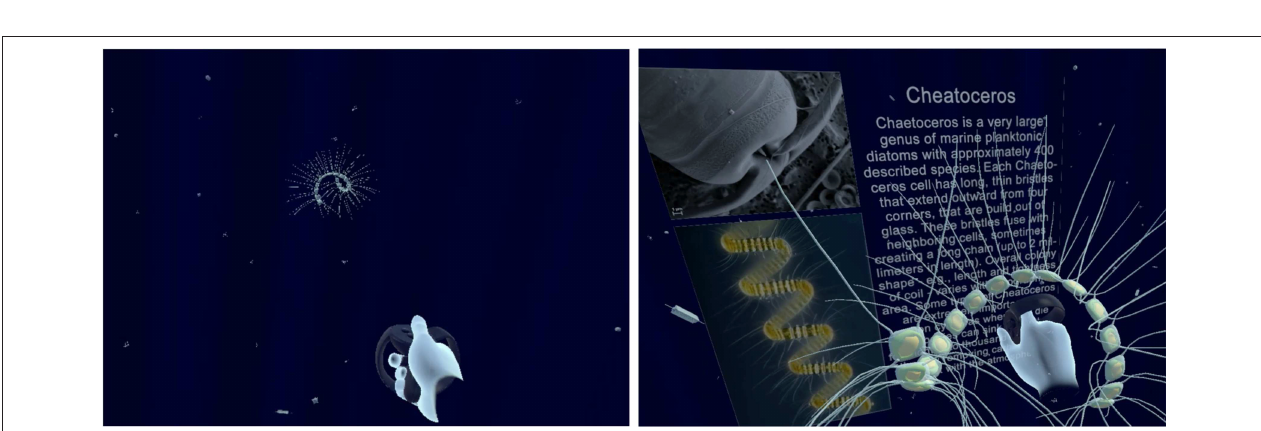
FIGURE 5 | Holographic microscope data was processed and rendered in VR at sea. (Left) A virtual reality “Holodeck” was set up inside the CTD control room of the R/V Falkor for viewing holographic microscope data that had been mapped to CTD profiles. Image credit: Schmidt Ocean Institute/Monika Naranjo Gonzalez. Written informed consent was obtained for the publication of this image. (Right) A user’s view inside the VR visualization of the holographic microscope data shows how easy it is to tag interesting objects and measure lengths using the Oculus Touch controllers.